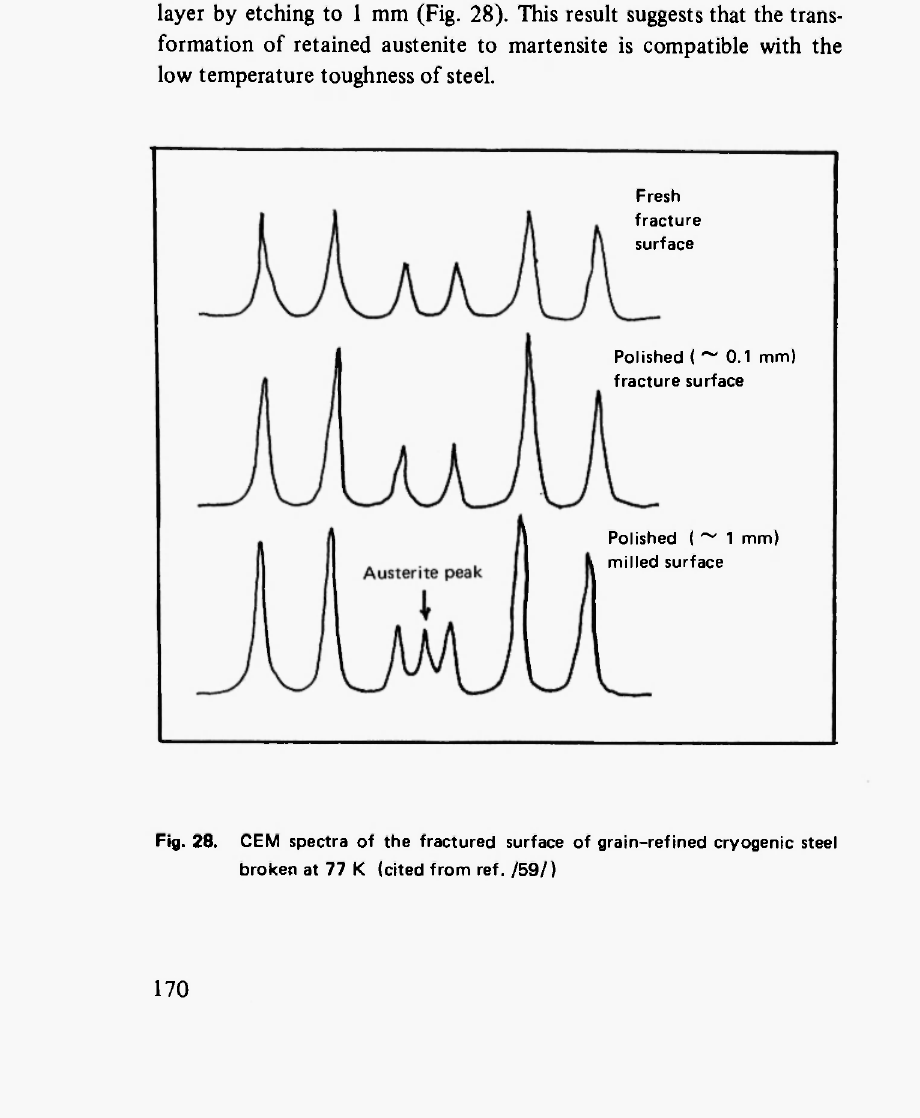
Fig. 28. CEM spectra of the fractured surface of grain-refined cryogenic steel broken at 77 Κ (cited from ref. /59/)